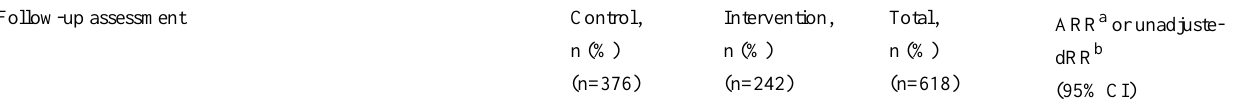
Table 2. Knowledge, risk perceptions, smoking behavior, intentions, and stage of change related to cigarette smoke exposure and breast cancer, by group allocation, at